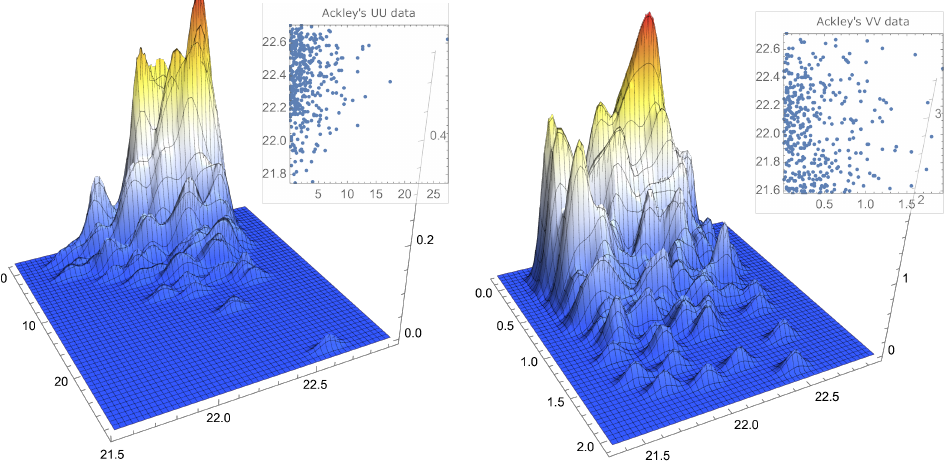
Figure 1. Smoothed histograms and simulation data for Ackley’s function.